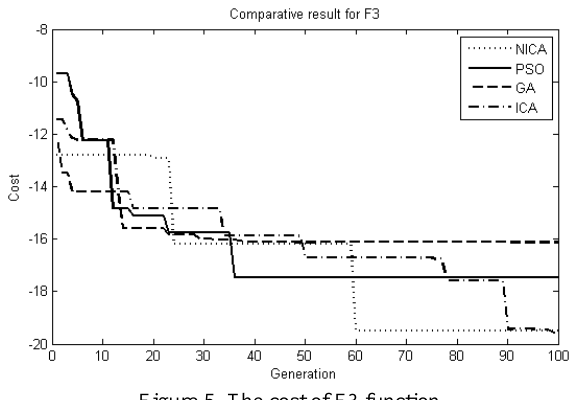
Figure 5. The cost of F3 function.